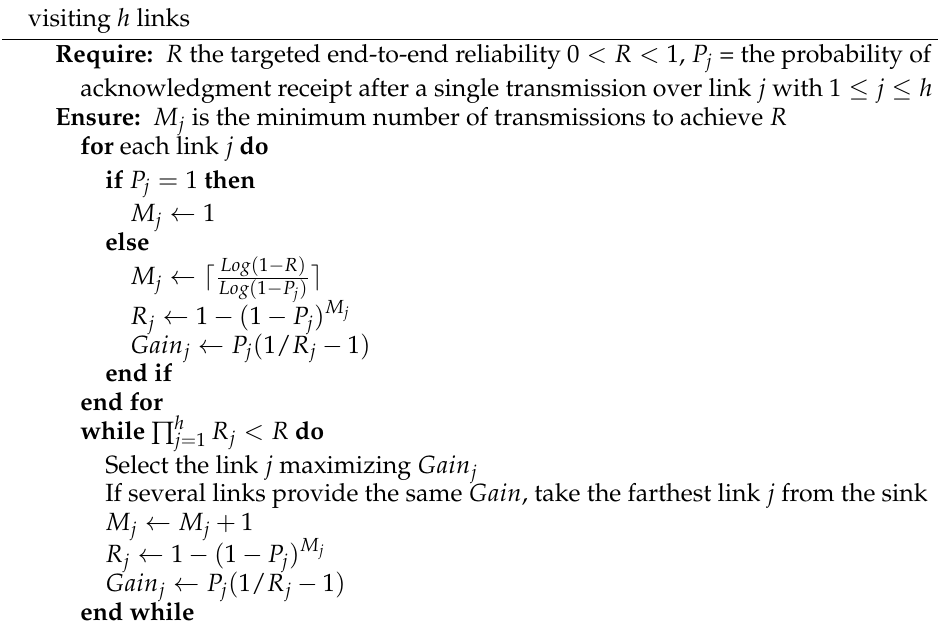
Algorithm 2: MOpt : Compute the number of transmissions M j on link j to achieve an end-to end reliability ≥ R and minimize the total number of transmissions per message of flow f visiting h